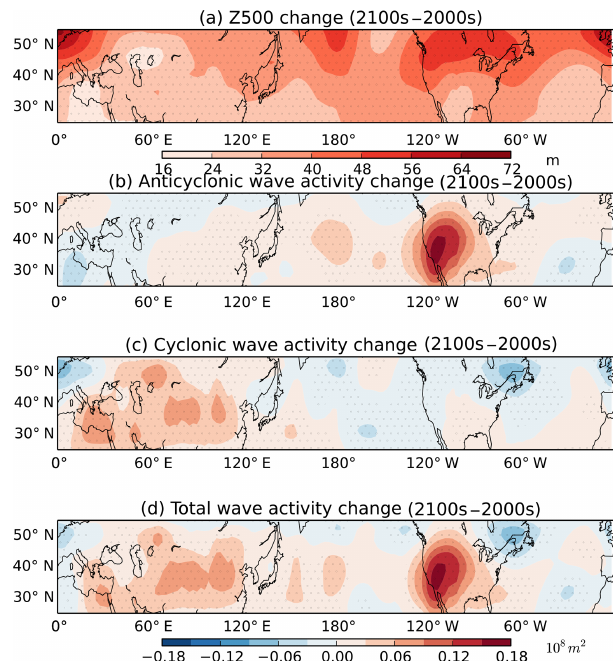
Figure 7. JJA-simulated difference between the GCM2100 and the GCM2000 for 500hPa geopotential height (m) (a) , anticyclonic wave activity (10 8 m 2 ) (b) , cyclonic wave activity (10 8 m 2 ) (c) , and total wave activity (10 8 m 2 ) (d) between 24 and 53 ◦ N. Note that in the Northern Hemisphere the cyclonic wave activity and total wave activity are negative. Here the change in magnitude is presented. Stippling represents where the change is significant at the 5% level using a Student t